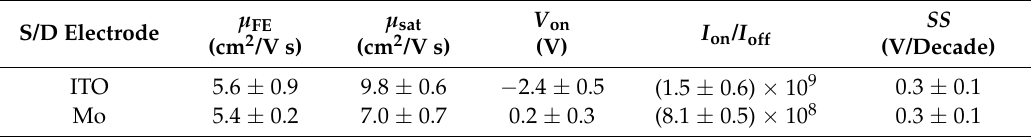
Table 1. Comparative table of device performance for amorphous STO-TFTs with ITO and Mo electrodes.